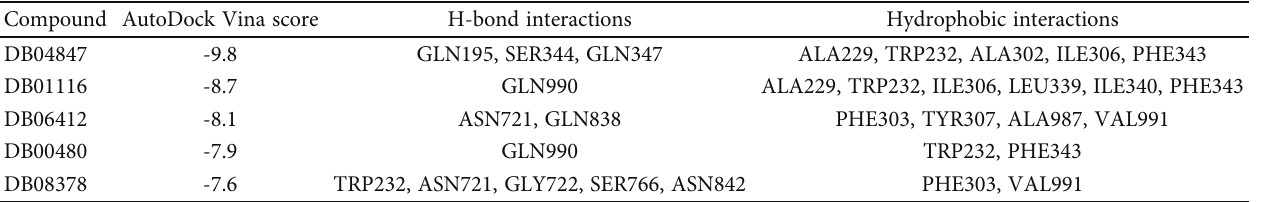
Figure 6: miRNA-mRNA relationship analysis: (a) miRNA-mRNA interaction relationship network; (b) diagnostic model of miRNA; (c) distance density fractionation plot of drug to TAP1-related gene set. Table 1: Molecular docking scores of compounds with TAP1 proteins and generated important